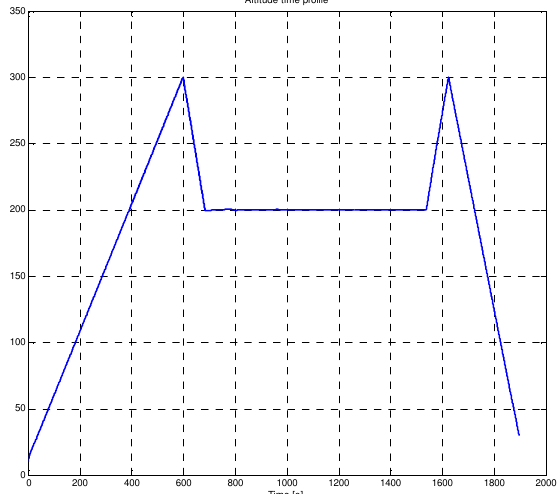
Fig 5. Altitude time profile. Altitude has been specified by user for each of the waypoints. The aircraft performed gradual